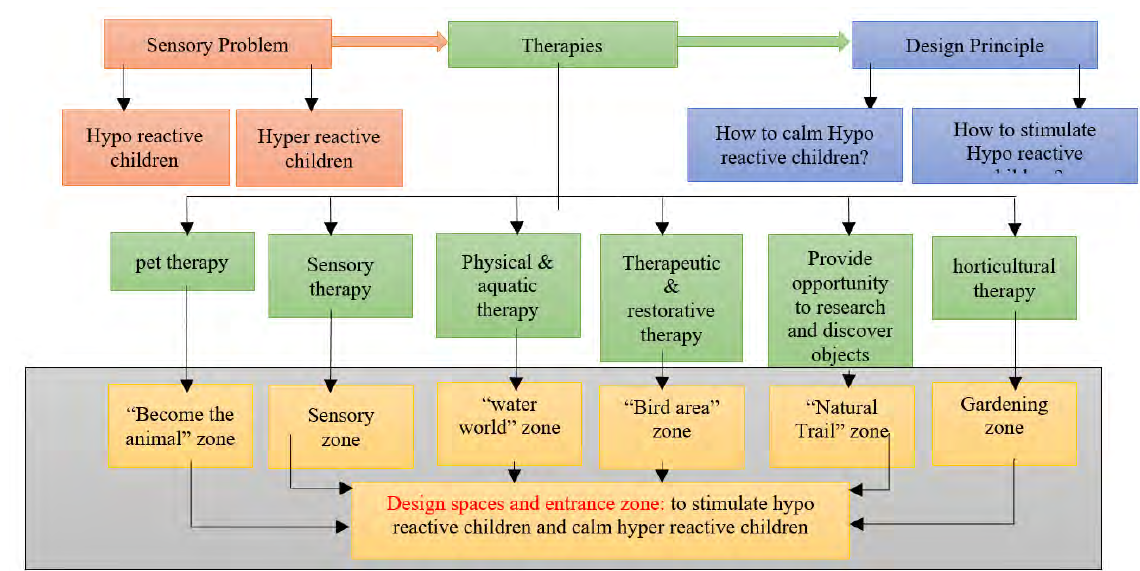
Figure 3. Diagram shows the design spaces